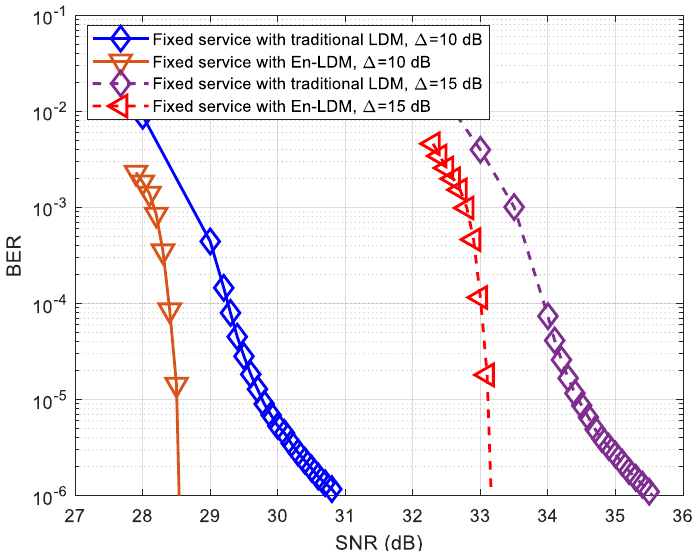
Figure 10. BER performance of fixed service with En-LDM and traditional LDM systems under the multipath channel, where the injection levels were set to ∆ = 10 and 15 dB, the CL constellation was set to QPSK, the EL constellation was set to NU−64QAM, the puncturing rate of the En-LDM scheme was set to 1/13, and the LDPC code rates of CL and EL were set to 5/15 and 11/15, respec- tively.